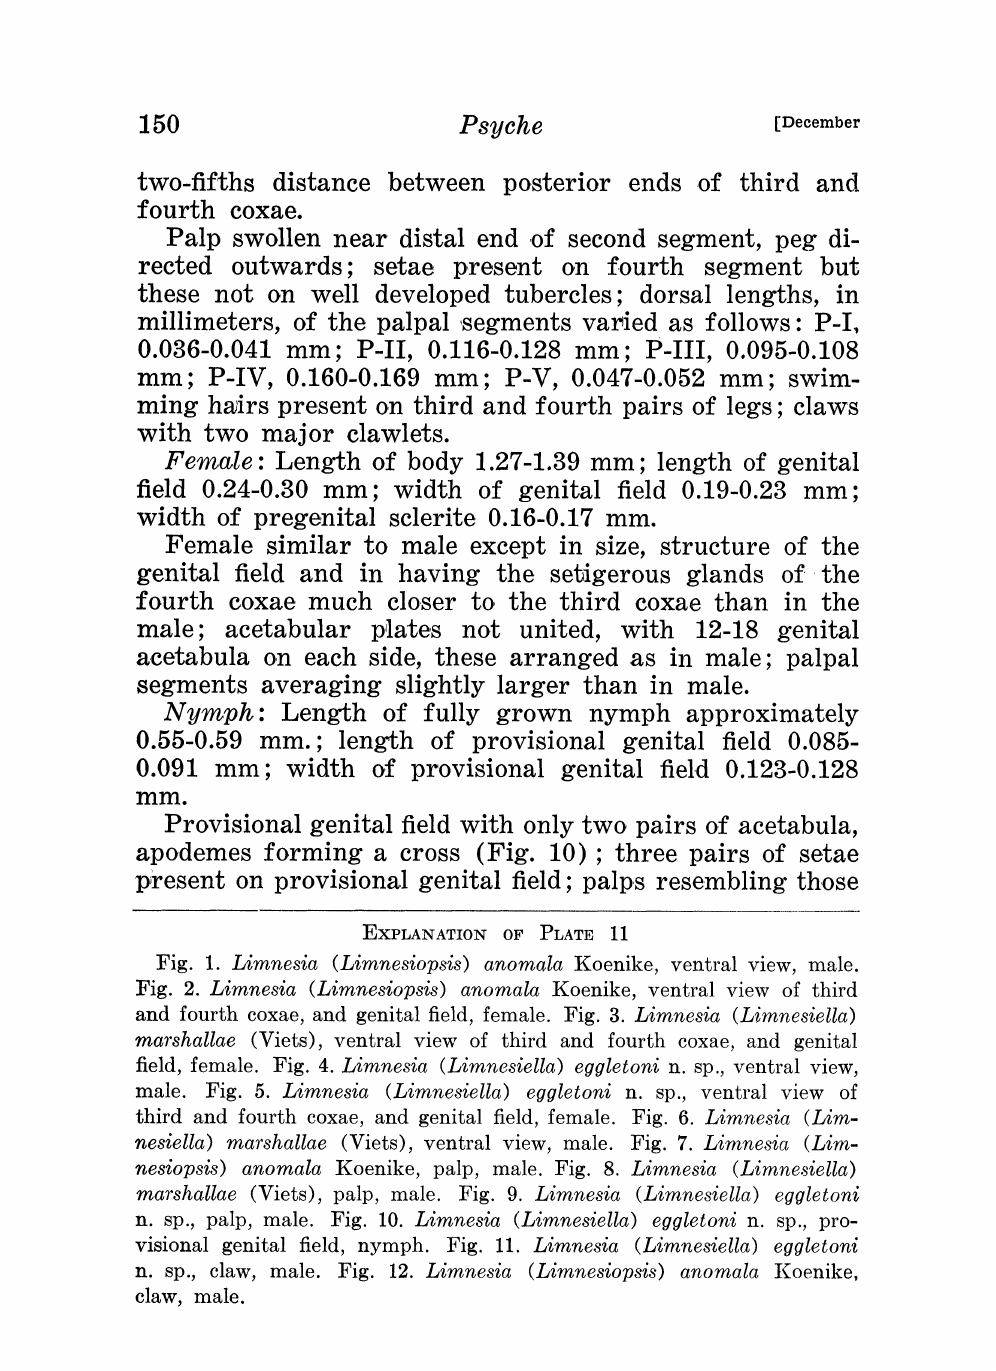
Fig. 1. Limnesia (Limnesiopsis) anomala Koenike, ventral view, male. Fig. 2. Limnesia (Limnesiopsis) anomala Koenike, ventral view of third and fourth coxae, and genital field, female. Fig. 3. Limnesia (Limnesiella) marshallae (Viets), ventral view of third and fourth coxae, and genital field, female. Fig. 4. Limnesia (LimnesielIa) eggletoni n. sp., ventral view, male. Fig. 5. Limnesia (Limnesiella) eggletoni n. sp., ventral view of third and fourth coxae, and genital field, female. Fig. 6. Limnesia (Lim- nesiella) marshallae (Viets), ventral view, male. Fig. 7. Limnesia (Lim- nesiopsis) anomala Koenike, palp, male. Fig. 8. Limnesia (Limnesiella) marshallae (Viers), palp, male. Fig. 9. Limnesia (Limnesiella) eggletoni n. sp., palp, male. Fig. 10. Limnesia (Limnesiella) eggletoni n. sp., pro- visional genital field, nymph. Fig. 11. Limnesia (Limnesiella) eggletoni n. sp., claw, male. Fig. 12. Limnesia (Limnesiopsis) anomala Koenike, claw,